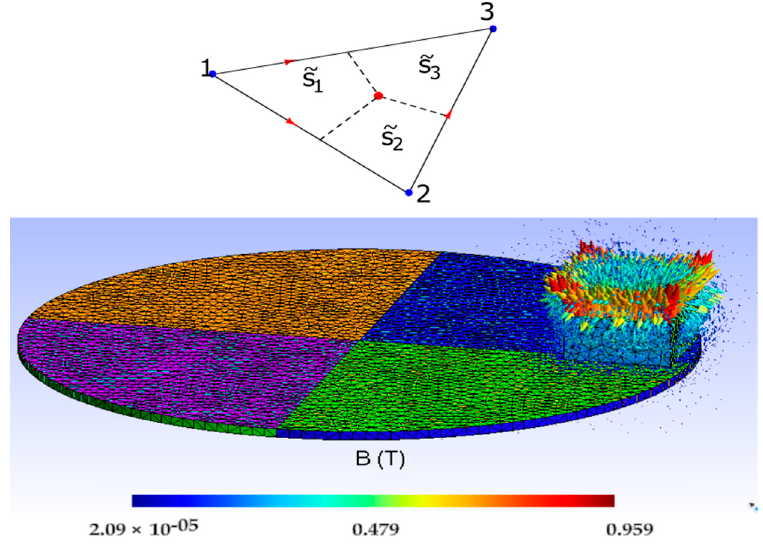
Figure 4. Triangle of reference 1, 2, 3 and dual surfaces 𝑆(cid:4634) (cid:2869) , 𝑆(cid:4634) (cid:2870) ,𝑆(cid:4634) (cid:2871) . Contour triangles on the disk.